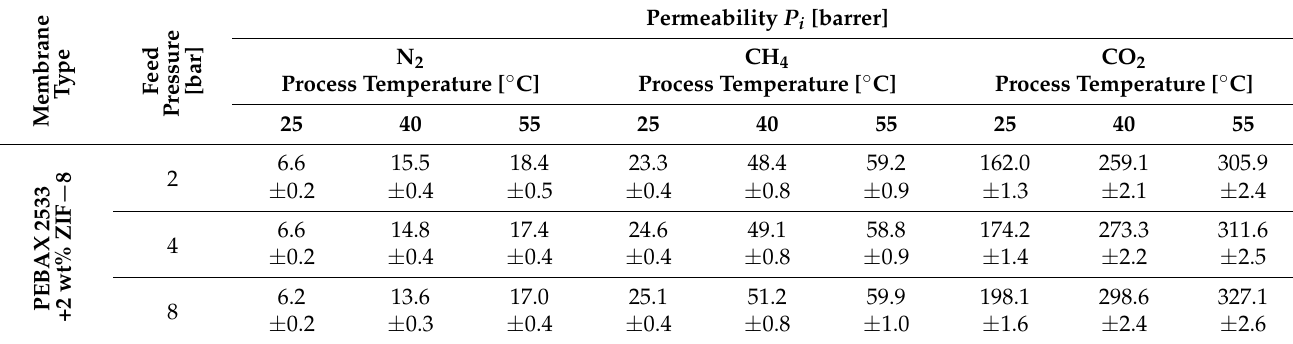
Table A3. Permeability of heterogeneous membranes containing ZIF − 8 to different gases measured for different feed pressure and temperature